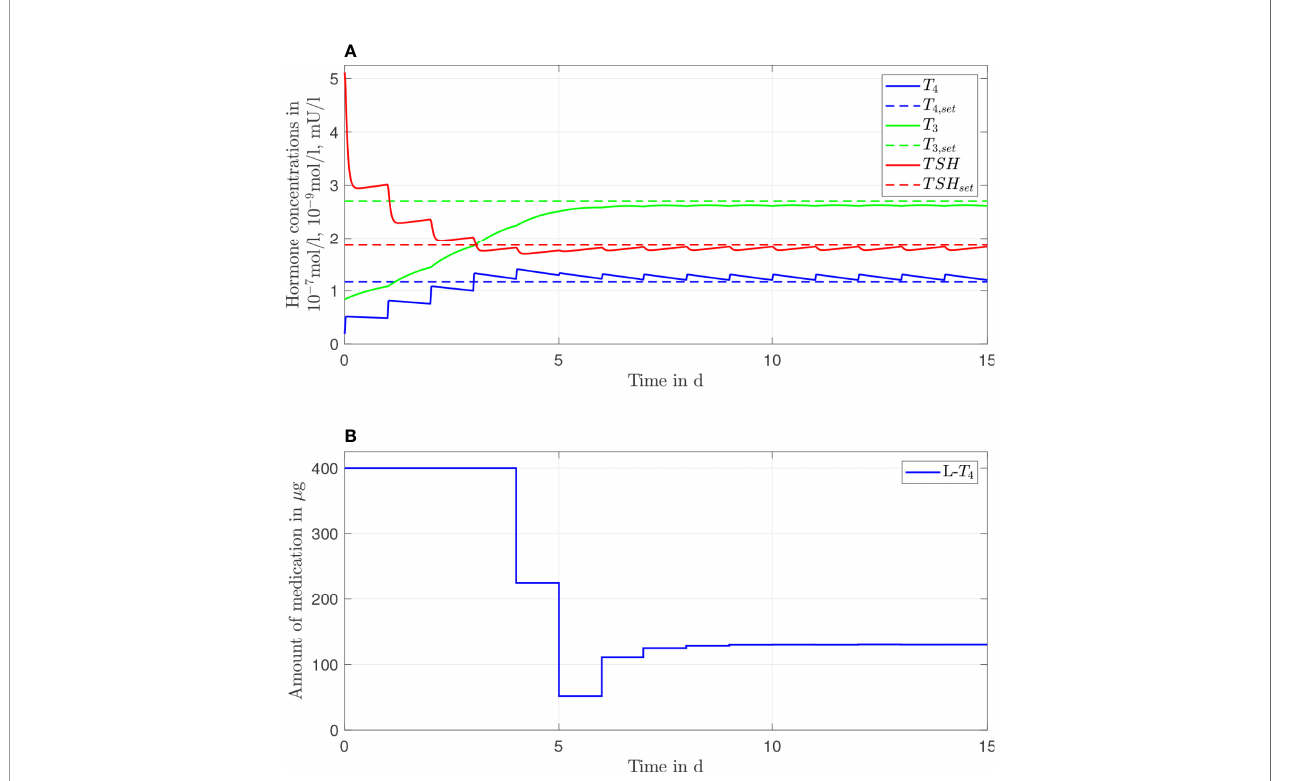
FIGURE 2 | Simulation results of an L-T 4 monotherapy for a generic hypothyroid patient. The hormone concentrations (A) result from the application of the thyroid hormone replacement dosages (B) , which are determined by means of an